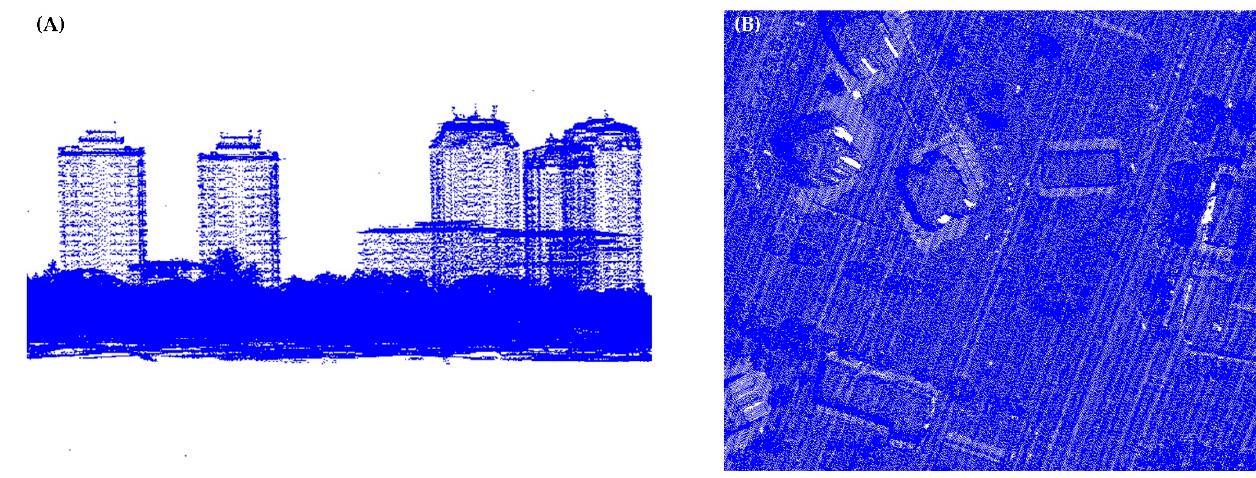
Figure 2. Example of the point cloud used in this study; ( A ) front view; and ( B ) top view. A 30 cm spatial resolution DSM, DTM, intensity, number of return (NOR), and DSM– DTM difference maps produced from a LiDAR point cloud were used to extract building footprints and determine their heights. To produce LiDAR derivatives, firstly, the noise points were eliminated by applying a statistical outlier filter (SOR) to the original point cloud. Using the filtered data, DSM, intensity and NOR maps were generated by linear interpolation. Ground points were extracted by applying a Cloth Simulation Filtering (CSF) algorithm to the point cloud to generate the DTM [37]. CSF parameters were set as topography: flat, cloth resolution: 0.5, maximum iteration: 1000, and classification threshold: 0.1 in extraction of ground points. Examples of the LiDAR derived data are given in Figure 3.